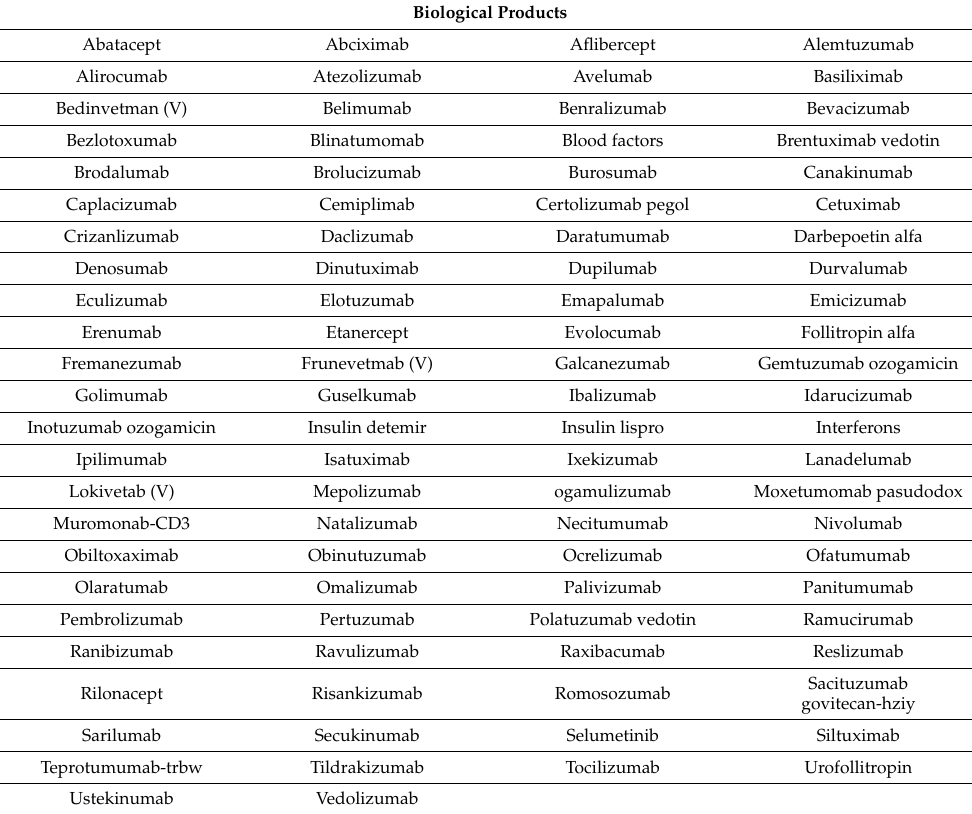
Figure 1. Comparison of approved biosimilar molecules in the EU and US. Created by the author from the data listed by the US FDA (https://www.fda.gov/drugs/biosimilars/biosimilar-product-information) and EU approvals from https://www.gabionline.net/biosimilars/general/biosimilars-approved-in-europe (Current as of 15 April 2022). Table 1. Potential biosimilar candidates with expired or near expiring patents *.